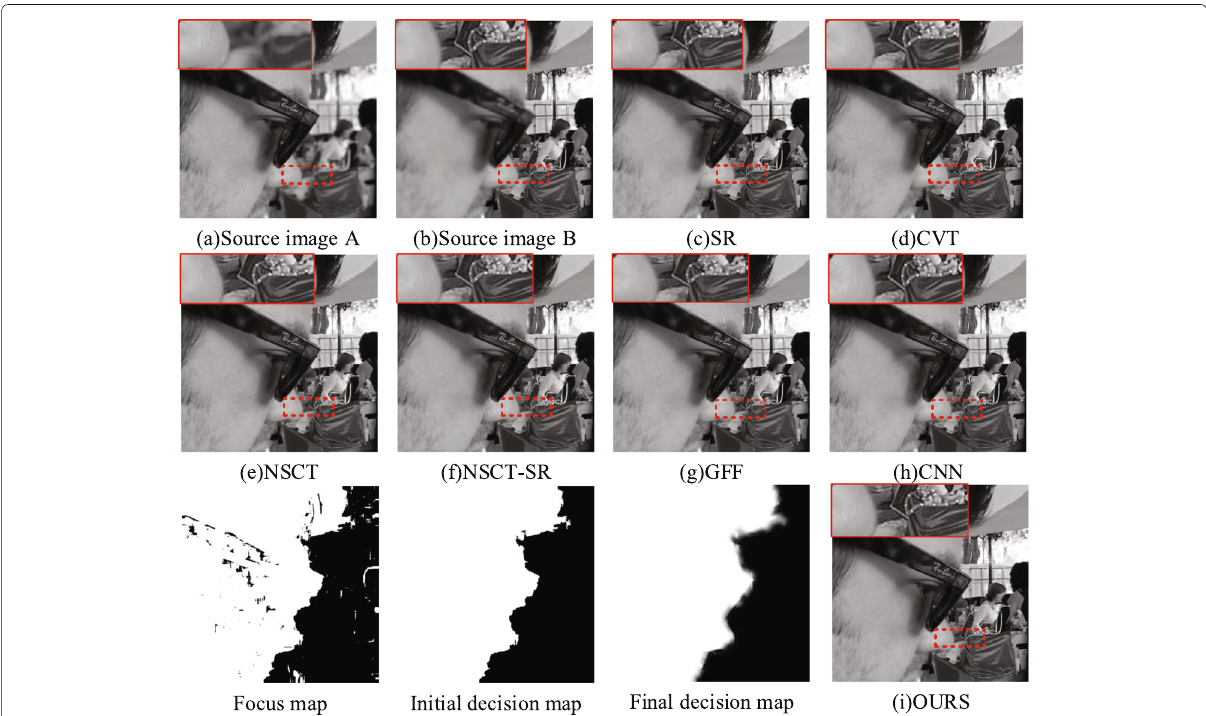
Fig. 9 Fusion results of “Profile” source images. Fusion results of different methods of “Profile” source images are presented. The border area of each fused image between focused and non-focused is displayed in the upper left corner to clearly distinguish the difference. Intermediate fusion results of our methods are shown as focus map and decision map